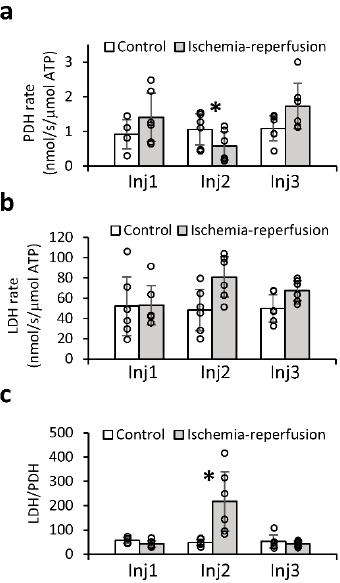
Figure 5. Production rates of [1- 13 C]lactate and [ 13 C]bicarbonate normalized to the ATP content of the slices. ( a - b ) Enzymatic activity relative to the ATP content of the slices (in nmol/s/ μ mol ATP), for PDH and LDH, respectively. In a, 16 injections were taken in total ( n = 4 for Inj1, n = 6 for each of Inj2 and Inj3). For b, 18 injections are taken in total ( n = 6 for each of three injections). ( c ) LDH to PDH activities ratio. The enzymatic activities were determined by the production rate of hyperpolarized [1- 13 C]lactate and [ 13 C]bicarbonate, respectively, ( n = 16 injections in total, n = 4 for Inj1 and n = 6 for each of Inj2 and Inj3). For each group, the ratio was determined per injection (dividing the averaged LDH activity of that injection to the PDH activity determined in the same injection), then averaged per injection number per group. PDH—pyruvate dehydrogenase, LDH—lactate dehydrogenase. Bars and error bars represent the mean and standard deviation, respectively. Circles mark values from individual injections. *—Significant difference.